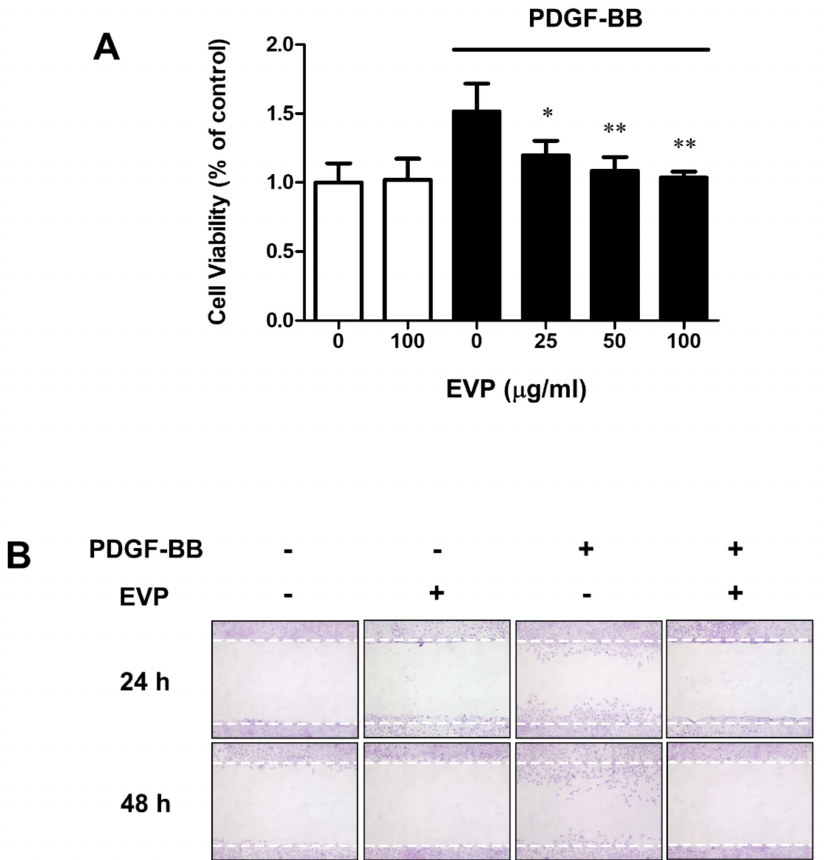
Figure 1. Effect of EVP on PDGF-BB induced VSMC proliferation and migration. ( A ) EVP inhibited PDGF-BB-induced proliferation of VSMCs. The cells were pre-cultured in serum-free medium for 22 h and then treated with various concentrations of EVP in serum-free medium for 2 h. The cell viability of each group with or without EVP treatment was measured using an MTT assay 48 h after stimulation with 50 ng/mL PDGF-BB. ( B ) EVP inhibited PDGF-BB-induced migration of VSMCs. The cells were pre-cultured in serum-free medium for 22 h, then treated with various concentrations of EVP in serum-free medium for 2 h. Confluent VSMCs were wounded by scraping and allowed to migrate for 24 and 48 h. Data are expressed as mean ± S.E.M. ( n = 4); * p < 0.05, ** p < 0.01 compared with PDGF-BB-only treated